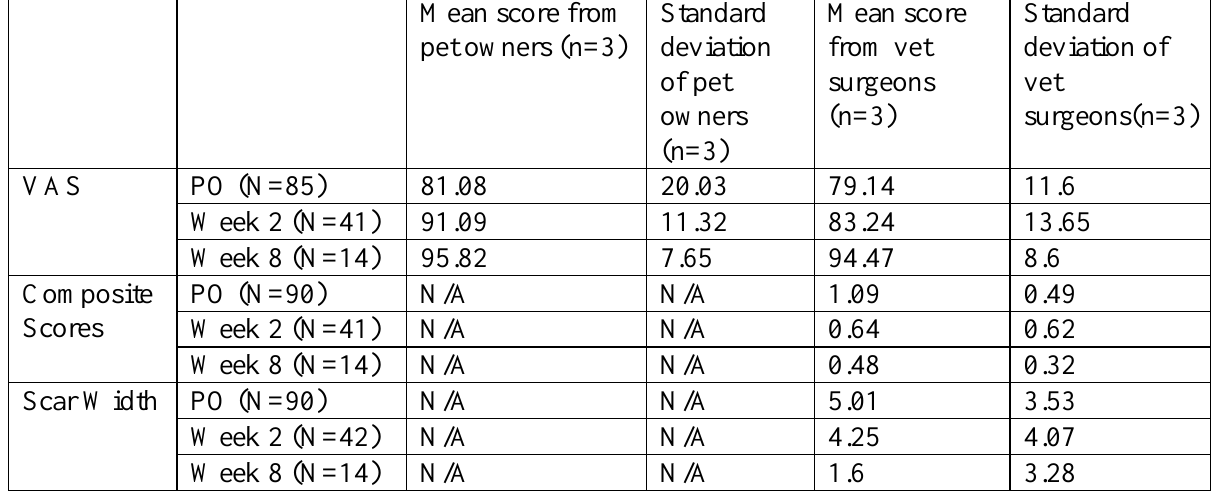
Table 1: Mean ± Standard Deviations of the VAS, Composite Score, and Wound